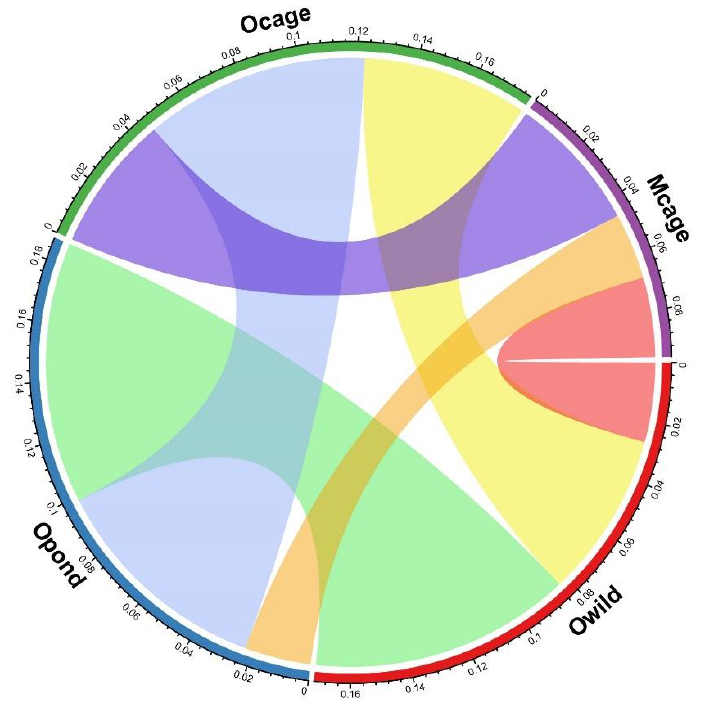
Figure 3. Chord diagrams based on average proximity scores from random forest classifications based on elemental fingerprints of Sparus aurata muscles collected at the four sampling origins. The wider alluvials represent higher average proximity scores between the paired sampling locations. Olhão – wild (Owild), Olhão – aquaculture in earth ponds (Opond), Olhão – sea-cage aquaculture (Ocage) and Madeira – sea-cage aquaculture (Mcage).